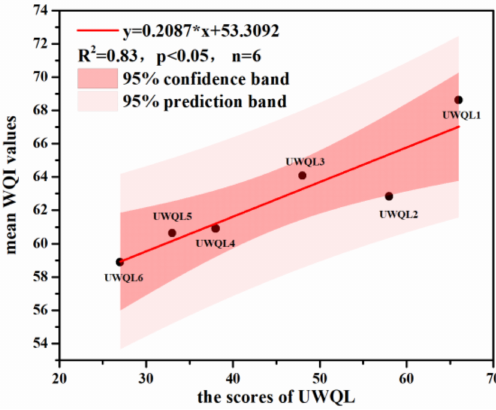
Figure 10. Scatter plot of the mean WQI values versus the scores of the